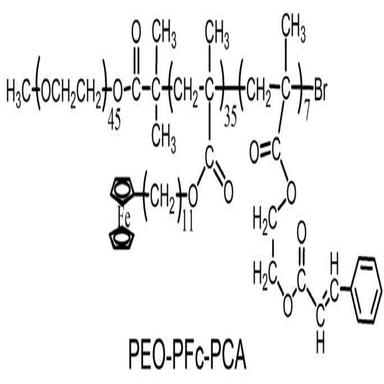
Structural representation of pseudocapacitor positive electrode material (PEO-PFc-PCA) containing ferrocene and cinnamic acid moieties.